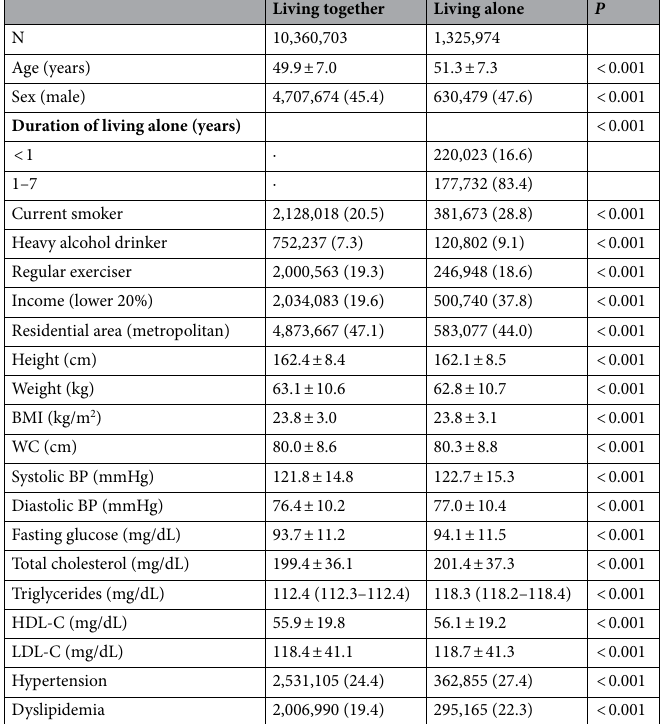
Table 1. Baseline characteristics of study participants according to living arrangement. BMI body mass index, WC waist circumference, BP blood pressure, HDL-C high-density lipoprotein cholesterol, LDL-C low-density lipoprotein cholesterol. Data are presented as mean ± standard deviation or number (%).